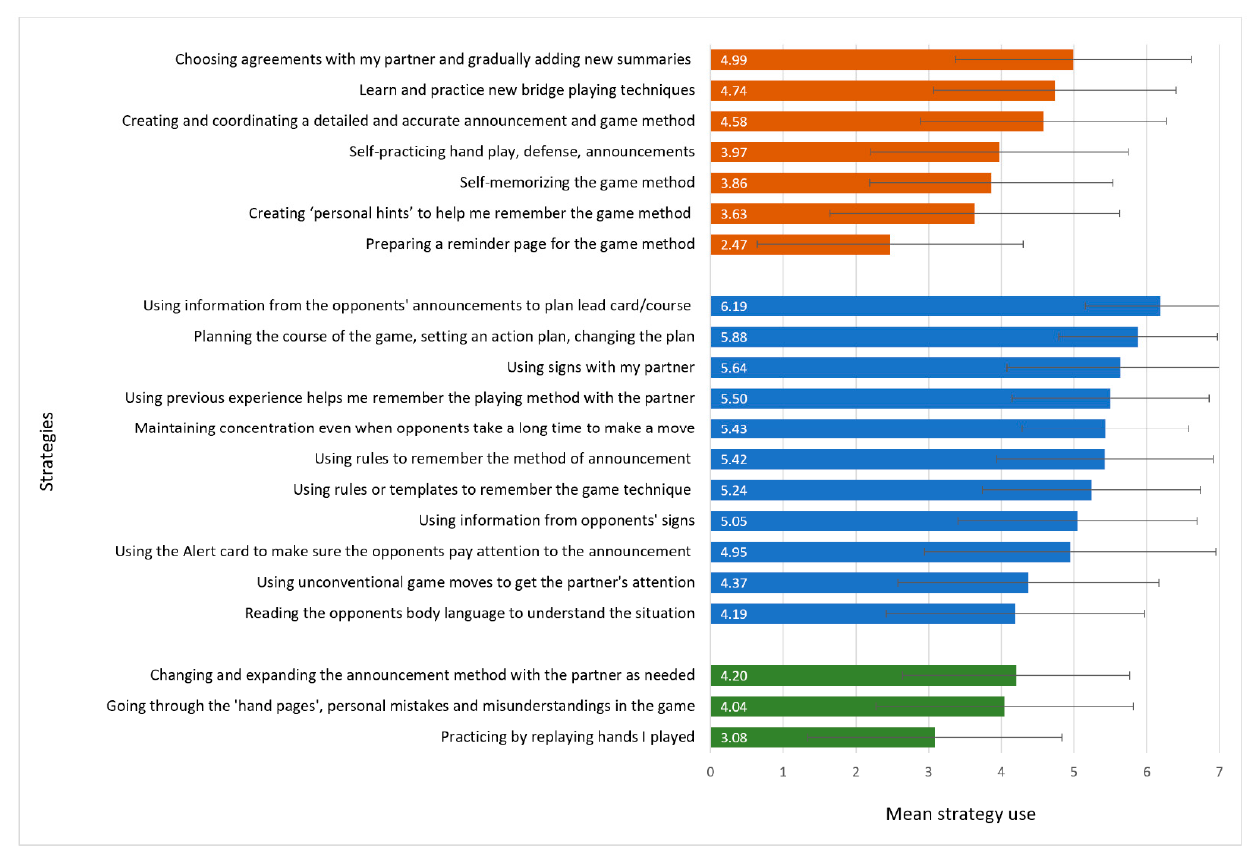
Figure 2. Mean levels of pregame (orange), in-game (blue), and postgame (green) strategy use according to the Bridge Cognitive Strategy Questionnaire.